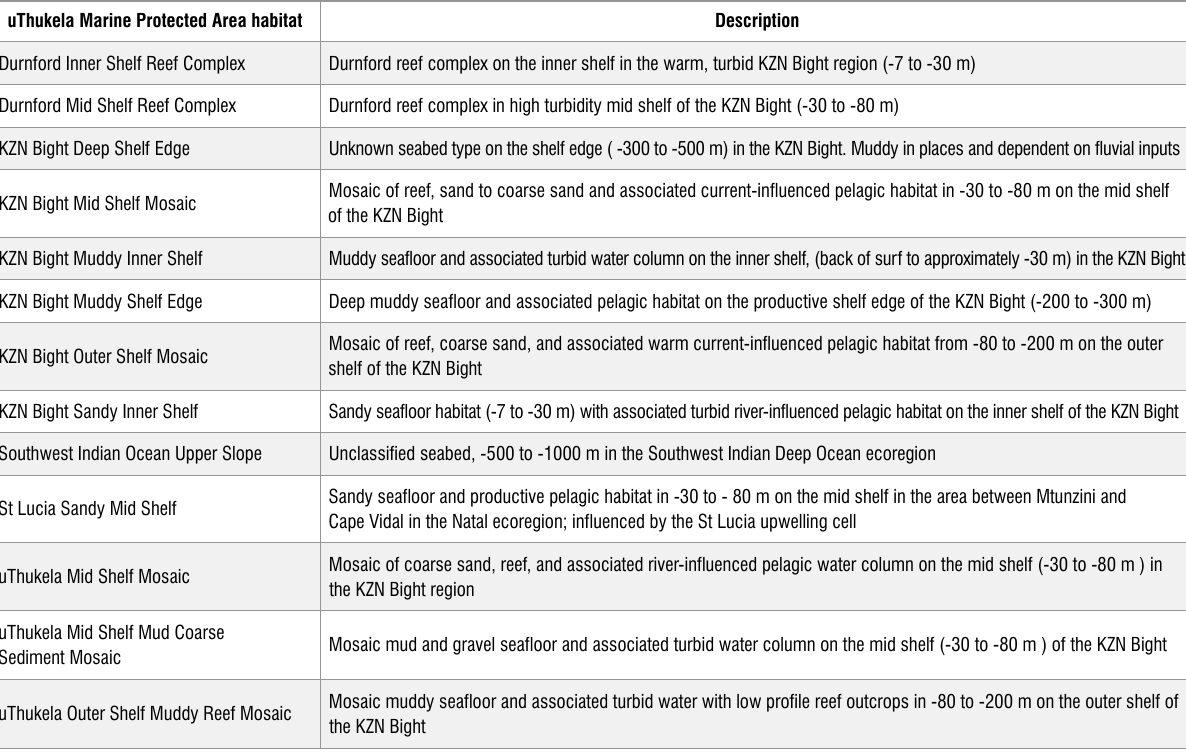
An overview of the seafloor geology/geomorphology and resulting ecosystem types of the uThukela Banks Marine Protected Area uThukela Marine Protected Area